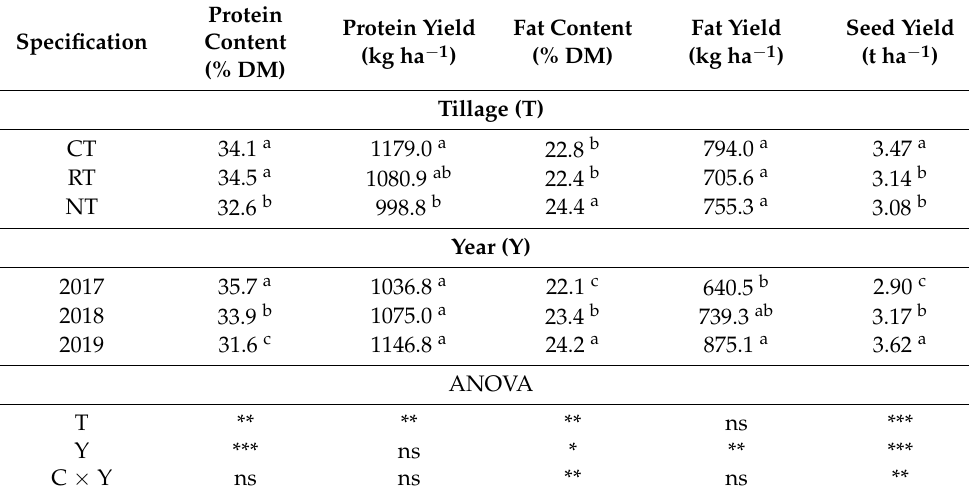
Table 4. Chemical seed composition and yield.